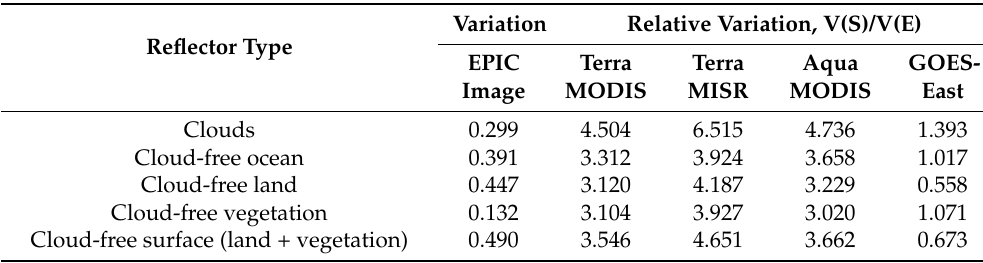
Table 2. Variation of reflector type fractions for 23 August